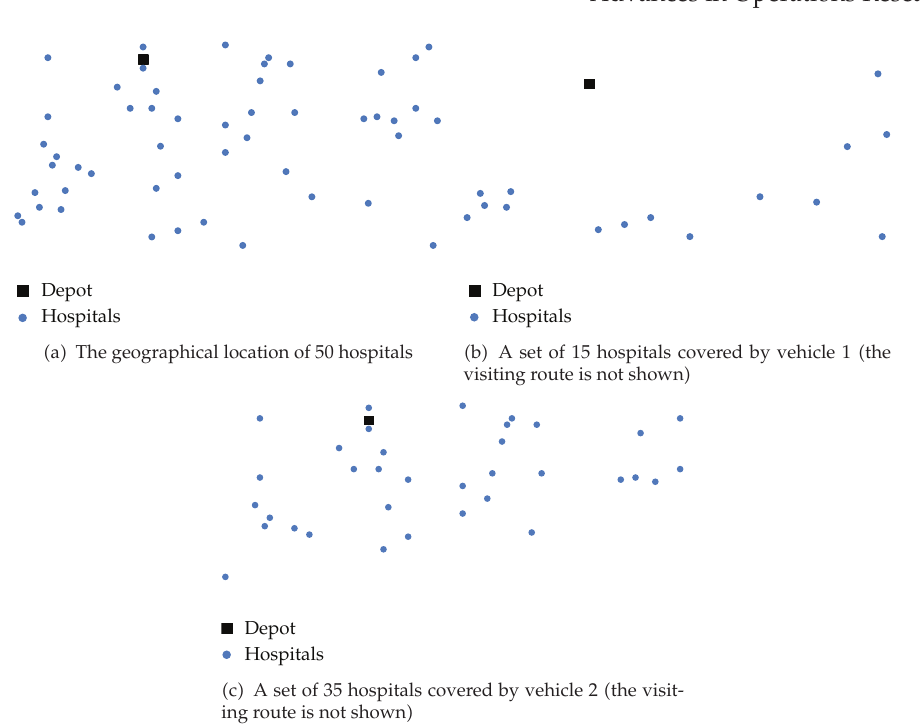
Figure 1: An illustration of the problem where 50 hospitals are covered by two